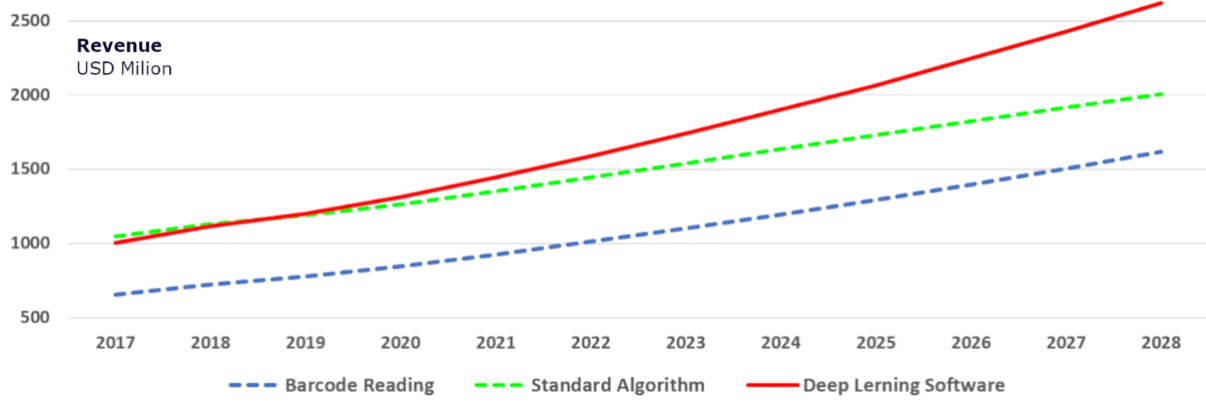
Figure 3. History and plans of the growth of robotization in the context of the use of vision systems by industry [54].